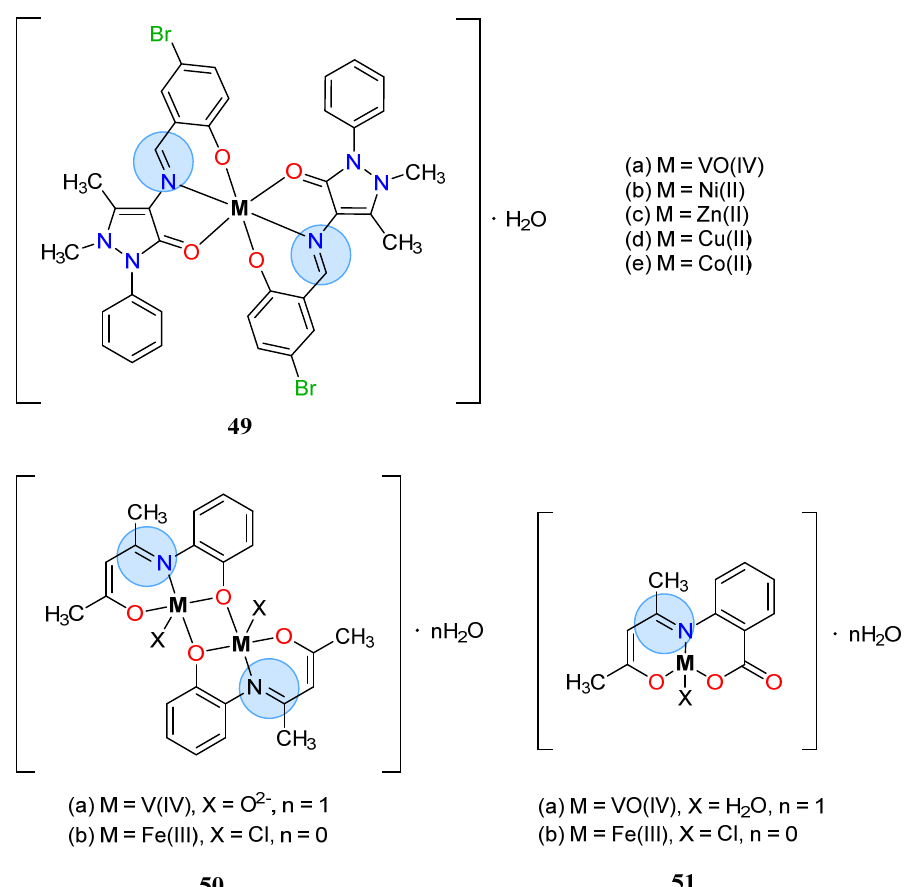
Figure 21. Metal complexes with ONO donor tridentate Schiff base ligands tested as antimicrobial agents.